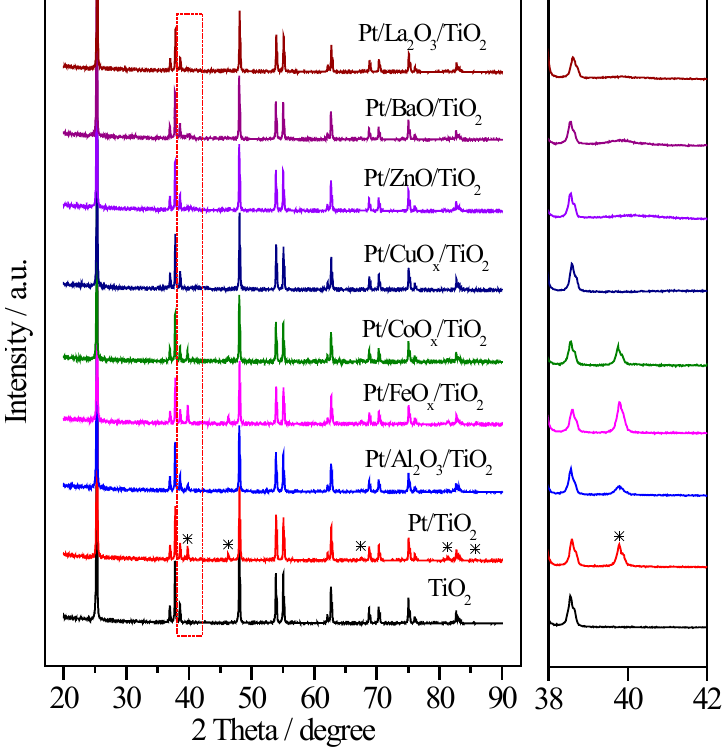
Figure 4. XRD patterns of Pt/MO x /TiO 2 catalysts collected after reaction testing. The XRD pattern of TiO 2 support is shown for comparison. (*: